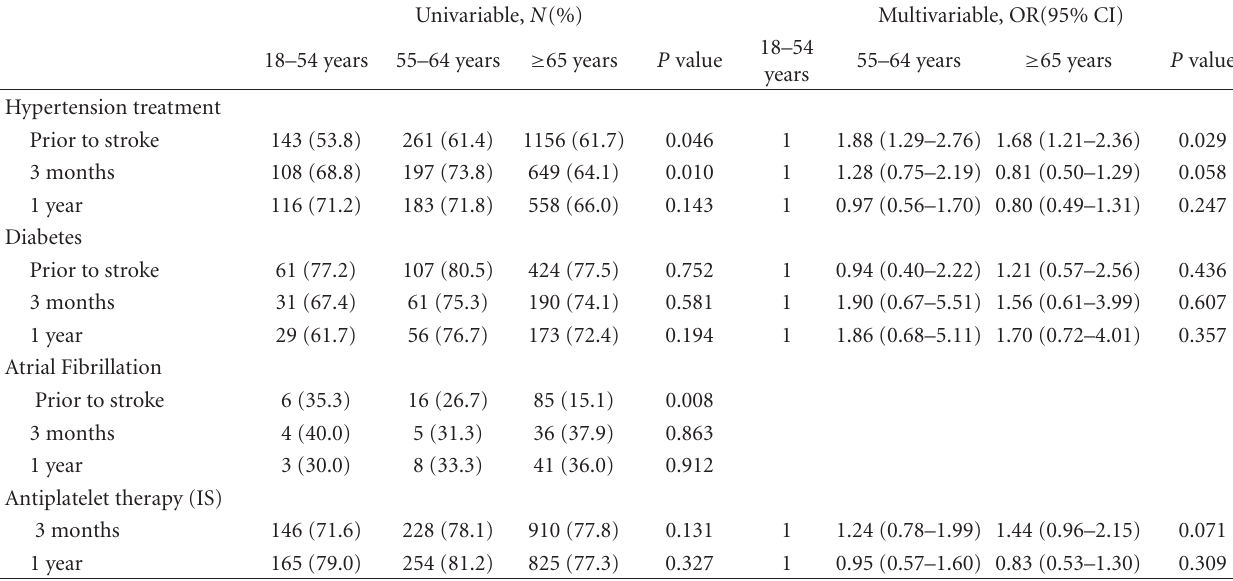
Table 4: Association between age and indicators relating to the management of risk factors.